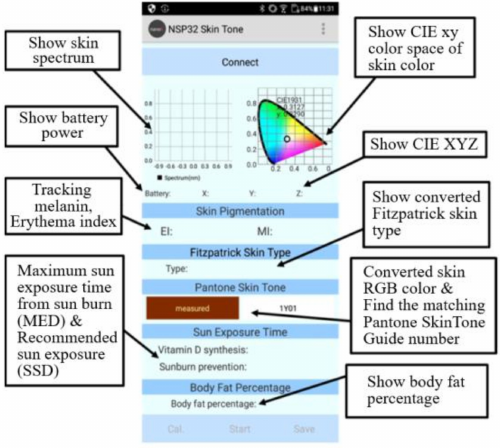
Figure 9. The app user